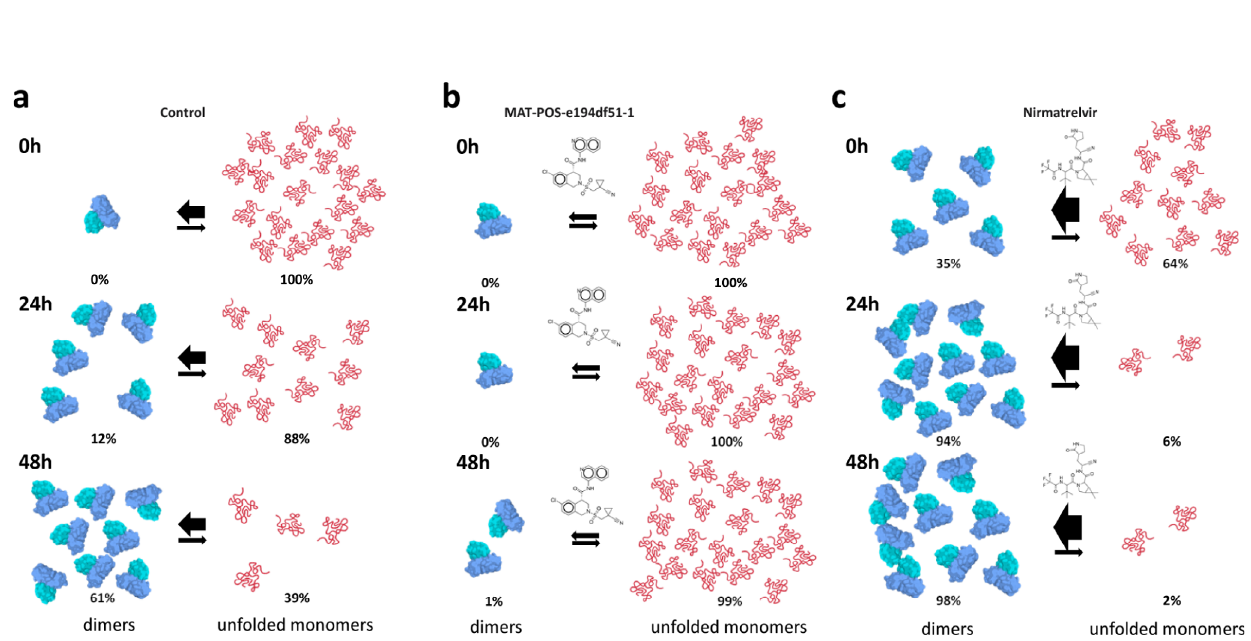
Fig. 5| Schematicrepresentation ofin solution dynamics ofSARS-CoV-2 C145S M pro monomeric form (sample 1) analyzed with SEC-MALS. a Control reaction containing monomers at 0h (top), after 24h incubation (middle) and after 48h (bottom). b Monomers conversion reaction in presence of non-covalent inhibitor